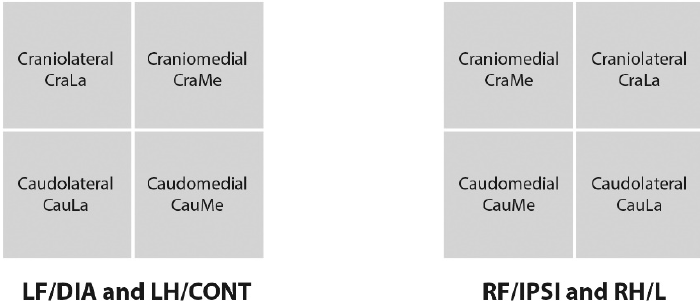
Figure 2. Quadrants nomenclature scheme. LF (left front limb); RF (right front limb); LH (left hind limb); RH (right hind limb); DIA (diagonal limb); IPSI (ipsilateral limb); CONT (contralateral limb); L (lame limb).